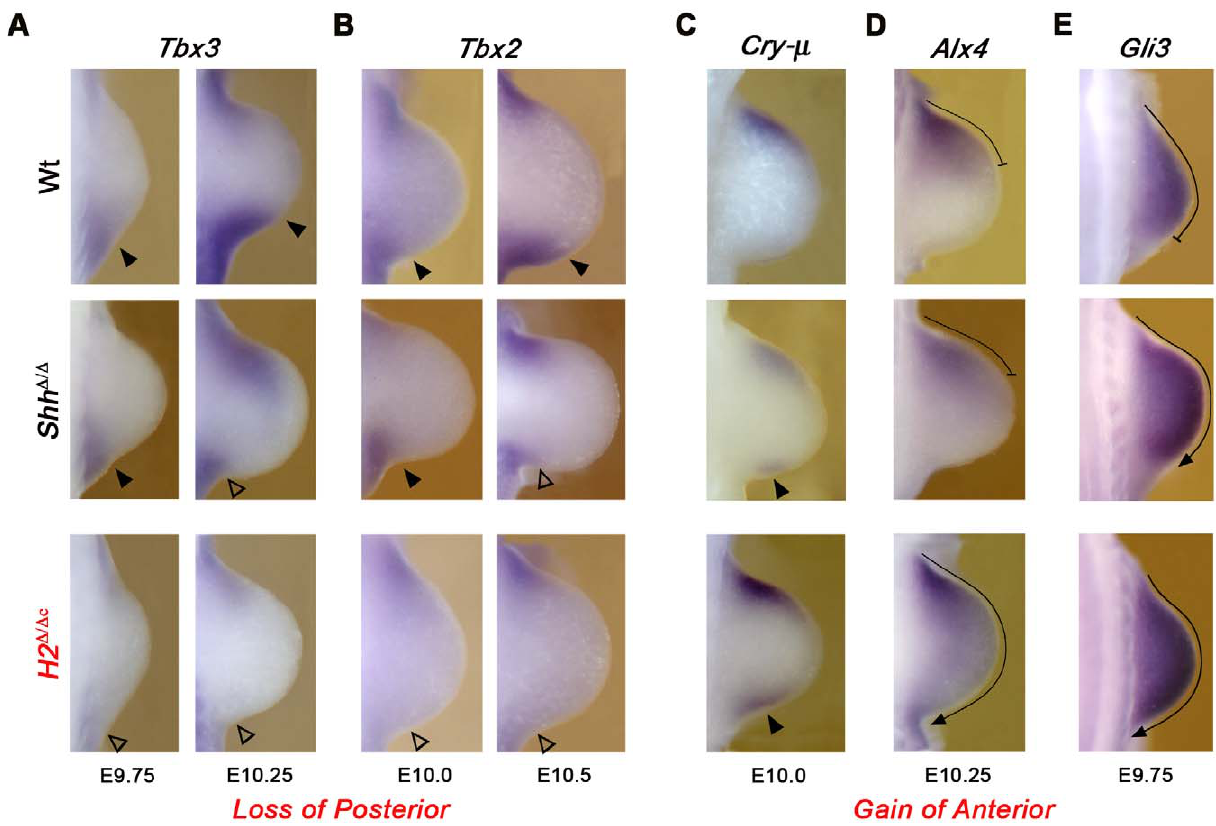
Figure 3. Establishment of posterior forelimb bud identity requires Hand2 . (A,B) The loss of the posterior Tbx3 and Tbx2 expression domains in early Hand2 deficient ( H2 D / D c ) limb buds (from E9.75: 27 somites to E10.5: 35 somites) points to a failure in establishing posterior identity upstream of Shh activation. Open arrowheads: loss of expression in Hand2 deficient forelimb buds; solid arrowheads: normal expression in wild-type and Shh deficient limb buds. By E10.25–10.5 the posterior expression of Tbx2 and Tbx3 is also down-regulated in Shh D / D limb buds. (C–E) Posterior expansion of anterior markers in H2 D / D c limb buds. (C) Crystallin- m ( Cry- m ) is expressed ectopically in the posterior mesenchyme of H2 D / D c limb buds at E10.0 (30 somites; indicated by solid arrowheads). The ectopic posterior Cry- m expression is detected earlier than in Hand2 than Shh deficient limb buds (not shown). The Alx4 (D) and Gli3 (E) expression domains are posteriorly expanded (indicated by arrows) in Hand2 deficient limb buds at E9.75 (27 somites) and E10.25 (32 somites), respectively. Note that the posterior expansion of the Gli3 expression domain is less pronounced in Shh D / D c than in H2 D / D c limb buds. In all panels, limb buds are oriented with the anterior to the top and the posterior to the bottom. Figure 4D and 4E. Conventional PCR using the amplicon ‘‘c’’ (Figure 4A) detected this ZRS region in chromatin precipitated with anti-Hand2 antibodies (lanes a -H2, Figure 4D), while no such amplification was detected when non-specific IgGs were used (lanes a -IgG; Figure 4D). To further analyze this apparent association of Hand2 containing chromatin complexes with the ZRS, three amplicons (‘‘b’’, ‘‘c’’, ‘‘d’’) probing different regions of the , 1.7 kb mouse ZRS (Figure 4A) were used for real-time PCR (Q-PCR) analysis. In addition, two amplicons located outside the mouse ZRS were chosen as likely negative controls (non-ZRS amplicons ‘‘a’’ and ‘‘e’’ in Figure 4A and 4E and Figure S5). Indeed, Q-PCR analysis revealed a minimally 14- fold enrichment of the amplicons located within the ZRS in comparison to the adjacent non-ZRS regions (Figure 4E). This enrichment is specific as ChIP using non-specific IgGs resulted in much lower Q-PCR amplification of all five regions. In particular, the enrichment of the ZRS in comparison to flanking non-ZRS regions is highly significant (amplicons ‘‘b’’ to ‘‘d’’ versus ‘‘a’’ and ‘‘e’’; p = 0.0018), while the variability among the three ZRS amplicons is not significantly different. Interestingly, the ZRS region encompassing amplicon ‘‘b’’, whose enrichment